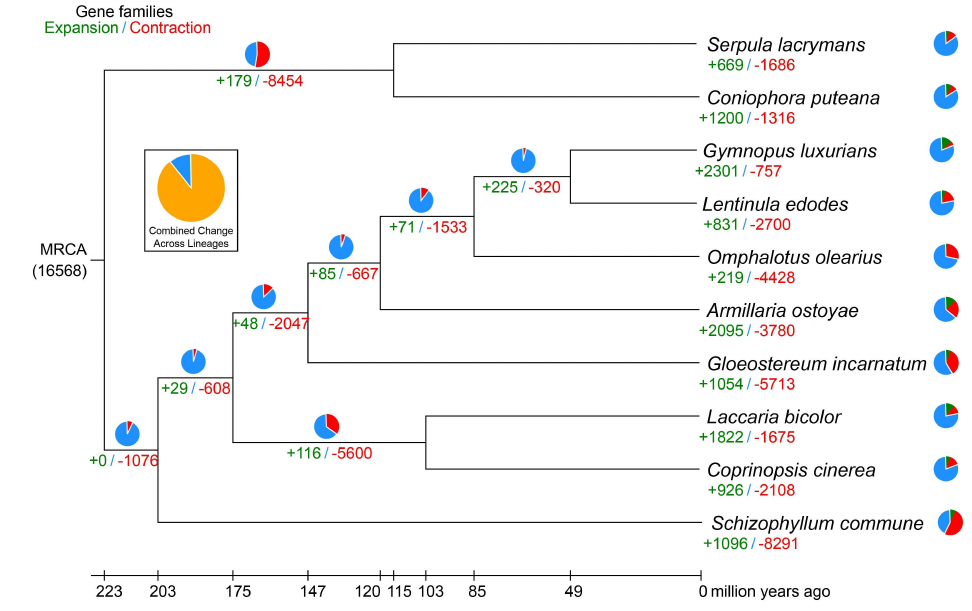
Figure 2. The Gloeostereum incarnatum genome evolutionary analysis. The number of expanded (green) and contracted (red) gene families is shown at each branch. The estimated divergence time (MYA: million years ago) is shown at the bottom. MRCA: most recent common